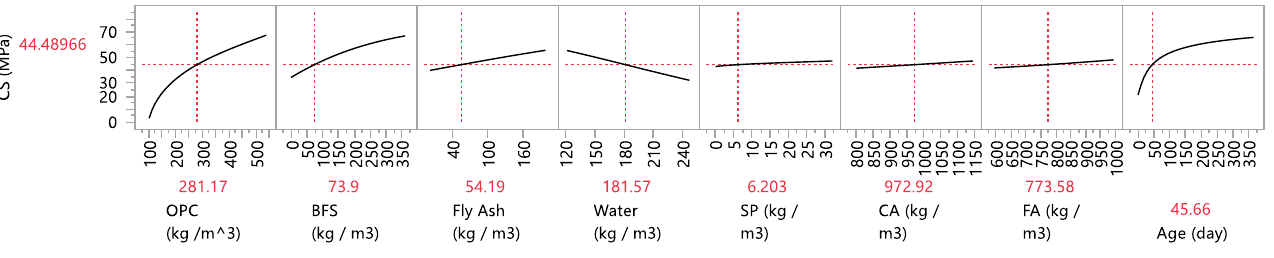
Figure 9. Prediction profiler of CS vs. eight factors.